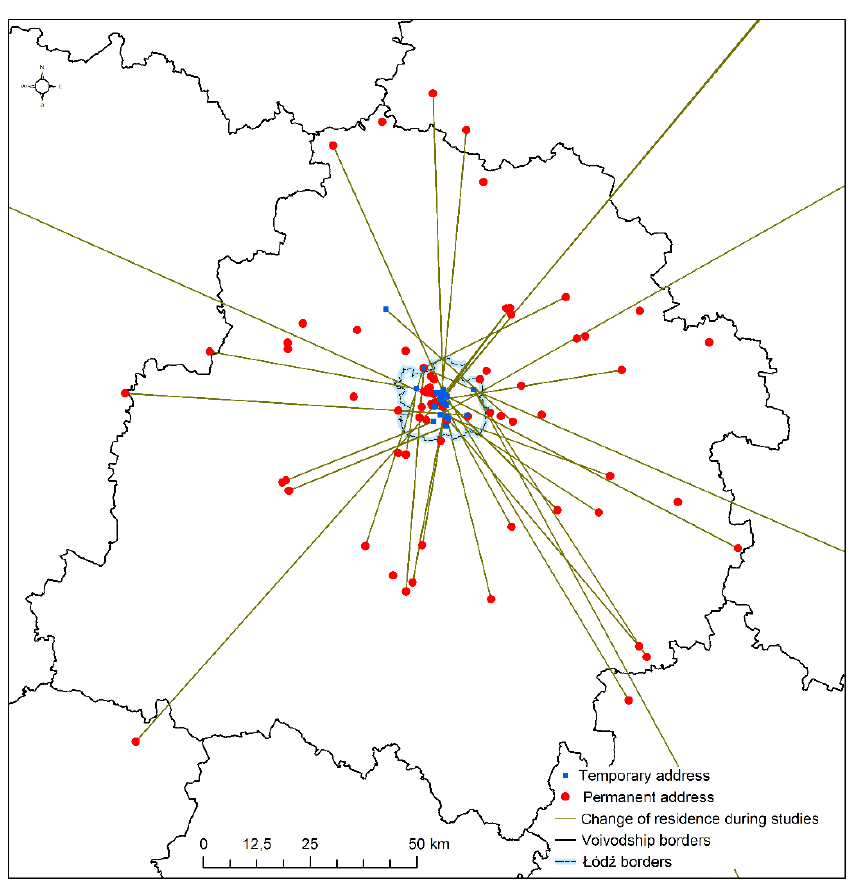
Figure 3. Change of residence of students of geoinformation at Faculty of Geographical Sciences at University of Lodz in the academic year 2016/2017.